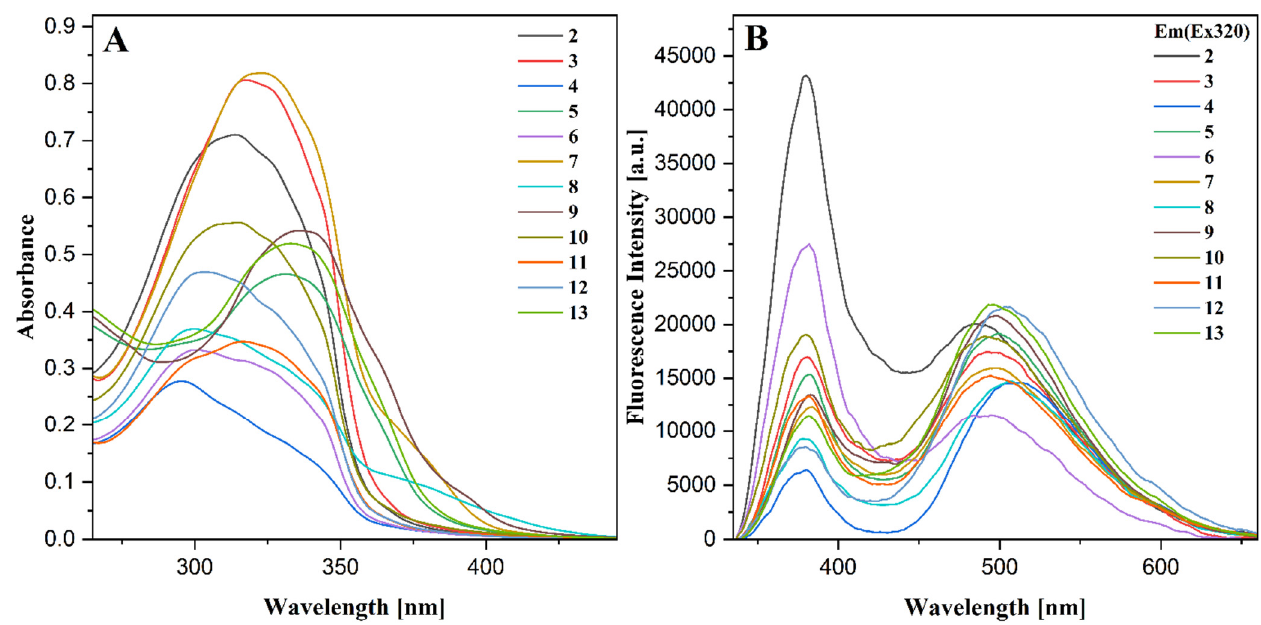
Figure 9. Electronic absorption spectra of 0.2 mM solutions ( A ) and fluorescence emission spectra 0.1 mM solutions ( B ) of coumarin-thiadiazole hybrids 2 – 5 and their corresponding Cu(II) and Zn(II) complexes 6 – 13 .